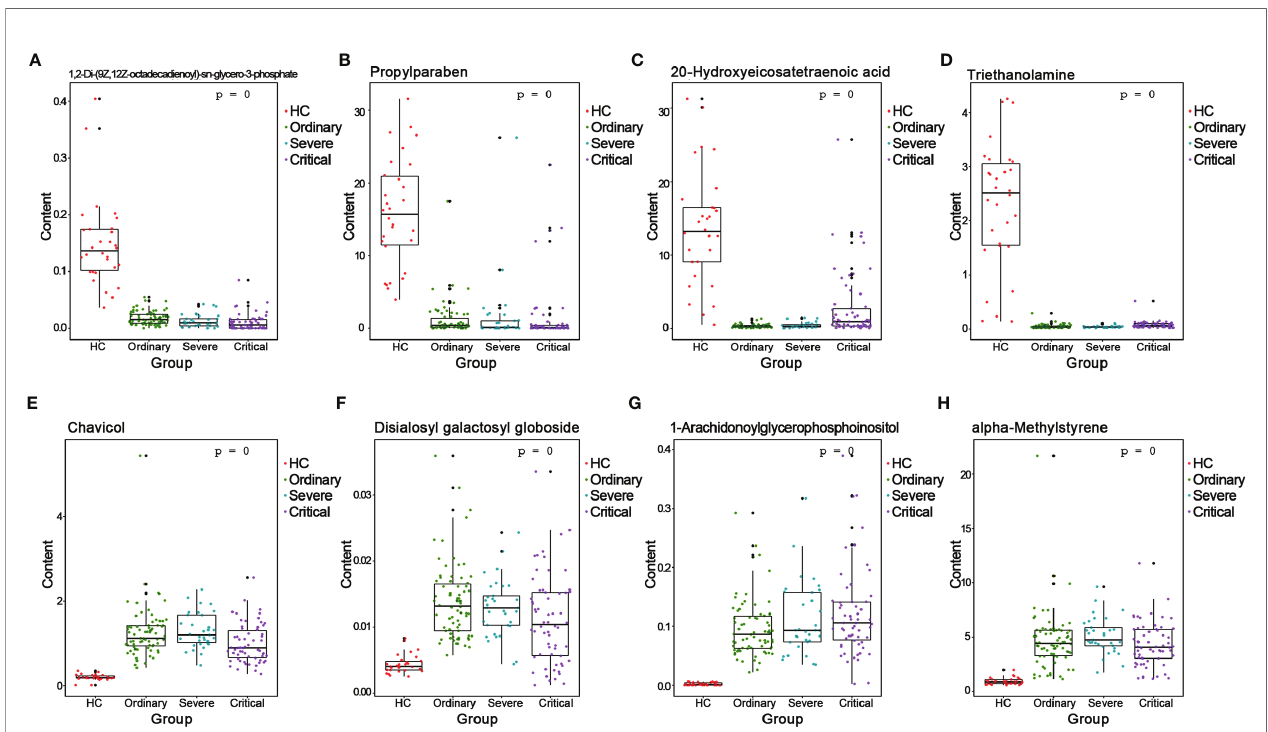
FIGURE 7 | Validation of the biomarkers of different COVID-19 outcomes. ROC>0.7 of metabolites is selected as the biomarkers. (A) 1,2-di-(9Z,12Z-octadecadienoyl)- sn-glycero-3-phosphate. (B) 1-arachidonoylglycerophosphoinositol. (C) 20-hydroxyeicosatetraenoic acid. (D) Alpha-methylstyrene. (E) Chavicol. (F) Disialosyl galactosyl globoside. (G) Ginsenoside Rh1. (H)